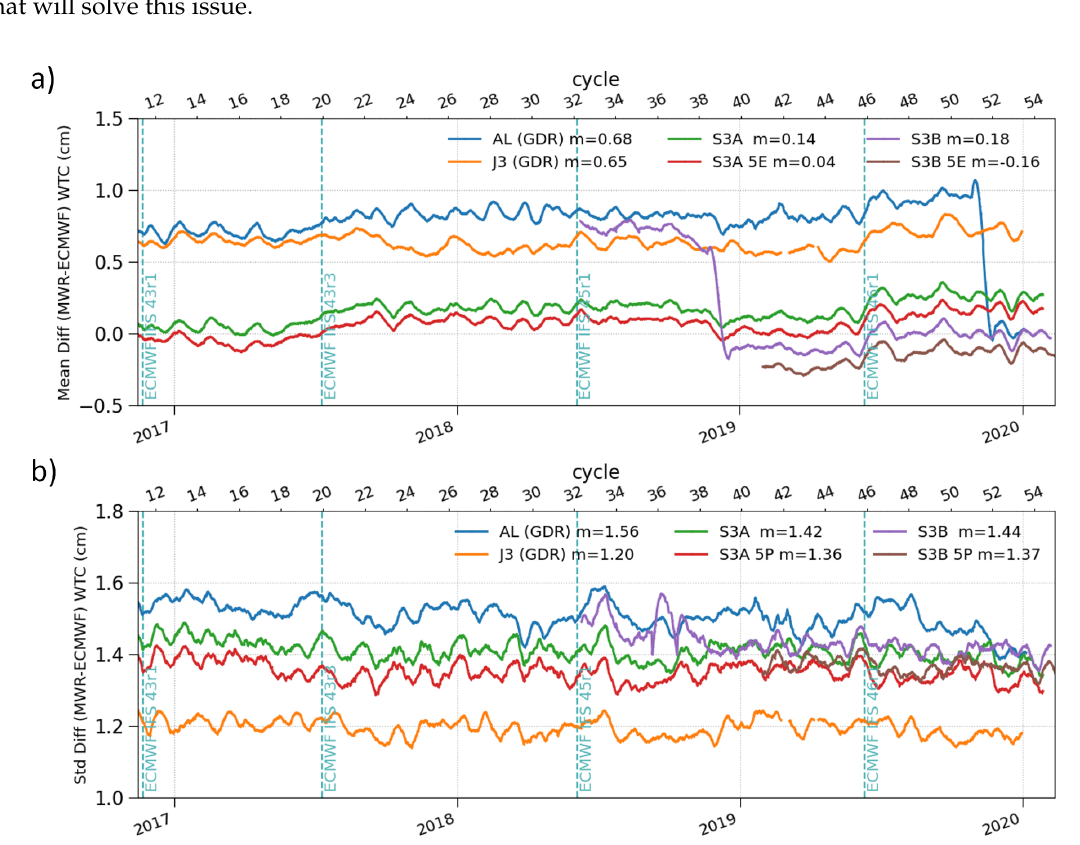
Figure 13. Comparison of MWR-derived corrections with those from ECMWF model. ( a ) Mean WTC difference ( b ) S.D. WTC difference. The vertical lines in cyan indicate changes in the ECMWF operational model used as the reference. Note, there was an update to the S3B characterization file in Dec. 2018, and the default AltiKa algorithm changed from 3-parameter to 5-parameter in Dec.